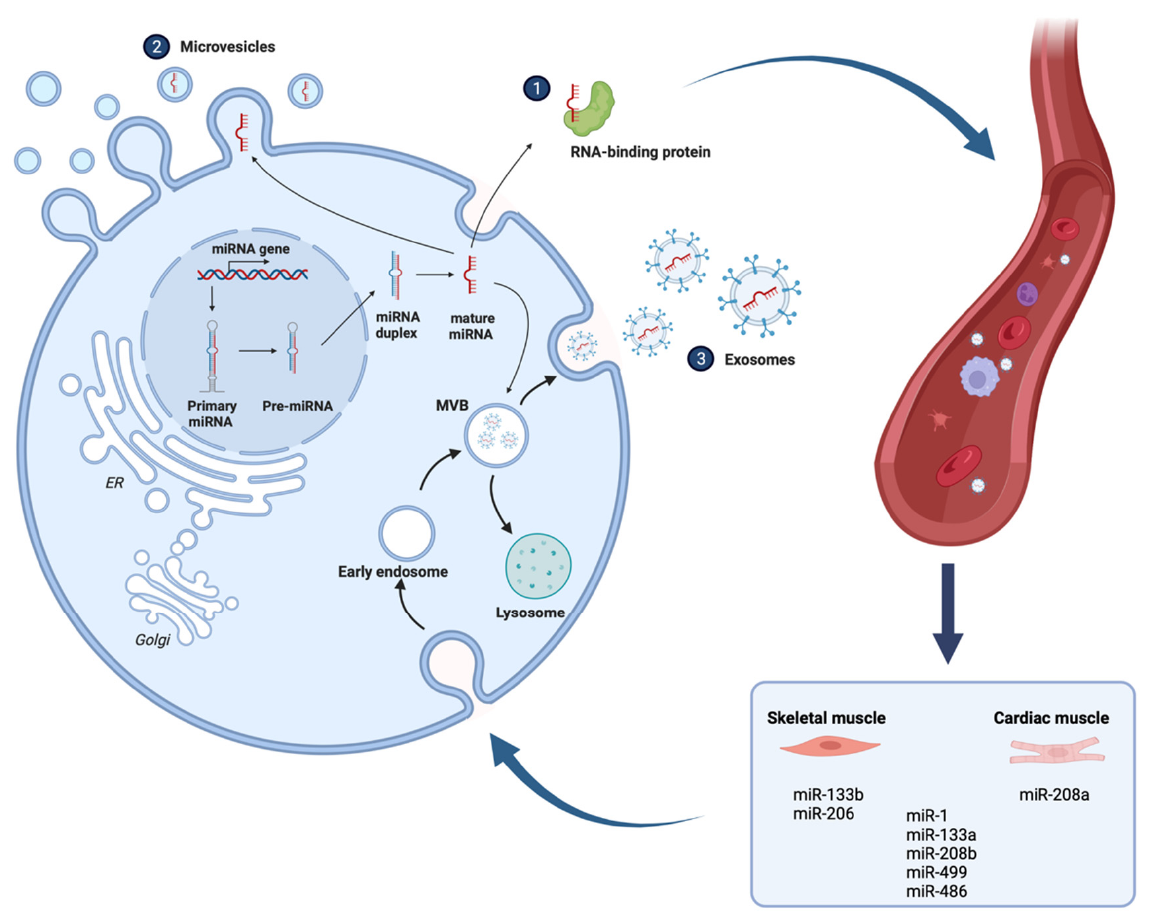
Figure 2. miRNAs can be secreted into extracellular fluids and transported to cells by binding to proteins or by being loaded into microvesicles or exosomes. The eight myomiRs are either expressed in both cardiac and skeletal muscle (miR-1, miR-133a, miR-208b, miR-486, miR-499) or exclusively in one type of muscle (e.g., miR-133b and miR-206 skeletal muscle, miR-208a cardiac). Created with